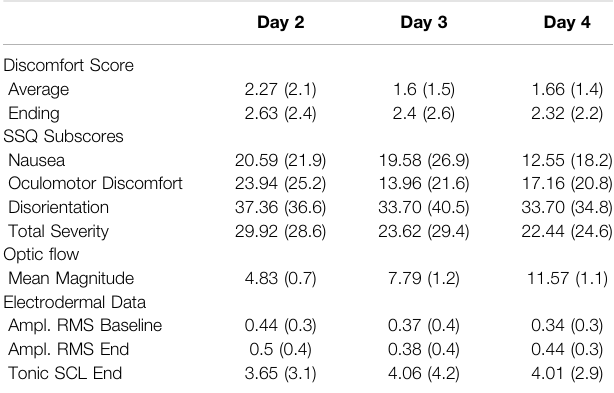
FIGURE 5 | Standardized tonic skin conductance level data averaged for each epoch (minute) during the experiment days. B — baseline SCL. TABLE 2 | Summary results of discomfort scores, simulator sickness questionnaire,optic fl ow, and electrodermal dataforthe training days interms of mean (standard deviation) .